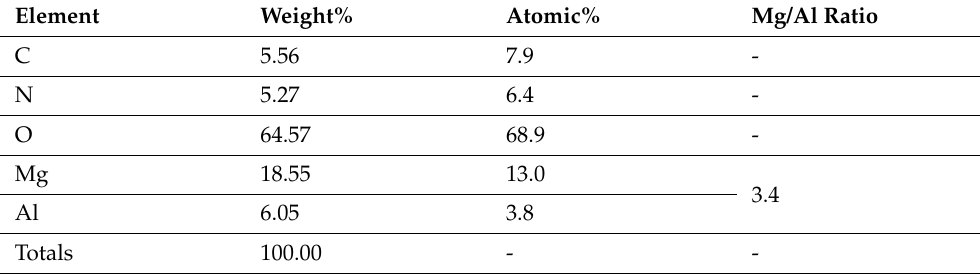
Figure 2. XRD profiles of: ( A )-(a) Degussa P25 showing anatase and rutile phases, ( A )-(b) synthesized uncalcined LDH, ( A )-(c) TiO 2 -modified LDH calcined at 250 °C (L:T ratio = 1:1). ( B ) LDH with the effect of calcination temperature (the synthesis temperatures are in the top-right corner). Table 3. EDX elemental composition of uncalcined LDH.